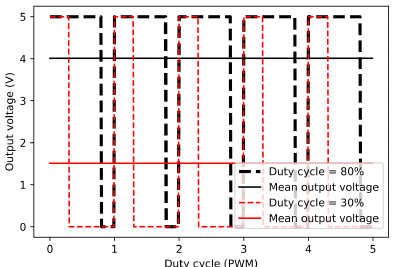
Figure 2. PWM signal with two different duty cycles, 80% and 30% in black and red dotted lines, respectively. In this example, the maximum output voltage is 5 VDC, hence an 80% duty cycle provides a mean output value of 4 VDC (solid black line), whilst a 30% duty cycle provides a mean output value of 1.5 VDC (red solid line. The frequency of actuation of the electromagnet is controlled by changing the time delay (DT) between the two duty cycle signals.